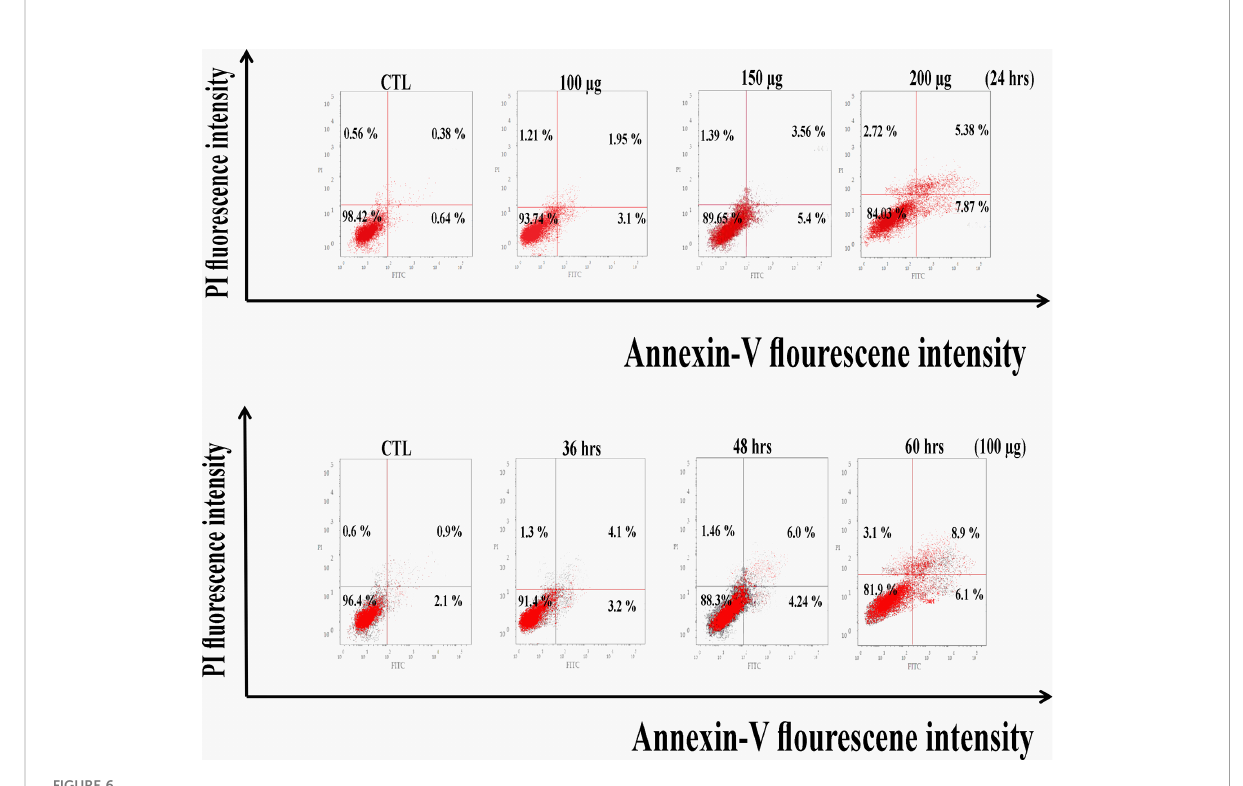
FIGURE 6 Apoptosis Assay with Annexin V-FITC/PI staining of Vero cell